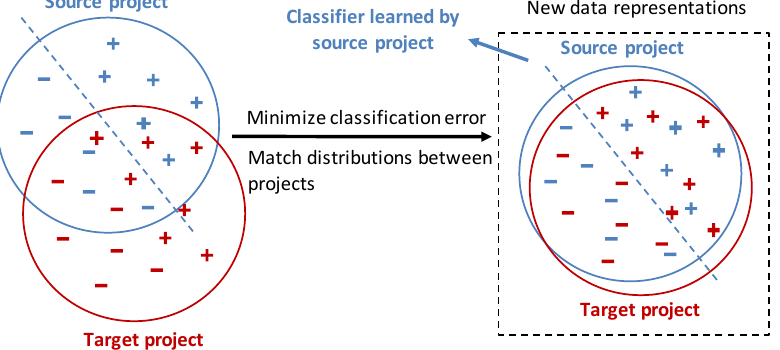
Figure 1. The data in different projects have distribution divergence, so that classifiers learned in a source project do not necessarily transfer well to the target project. If the distributions could be matched, it would enhance the transferability of the cross-project defect